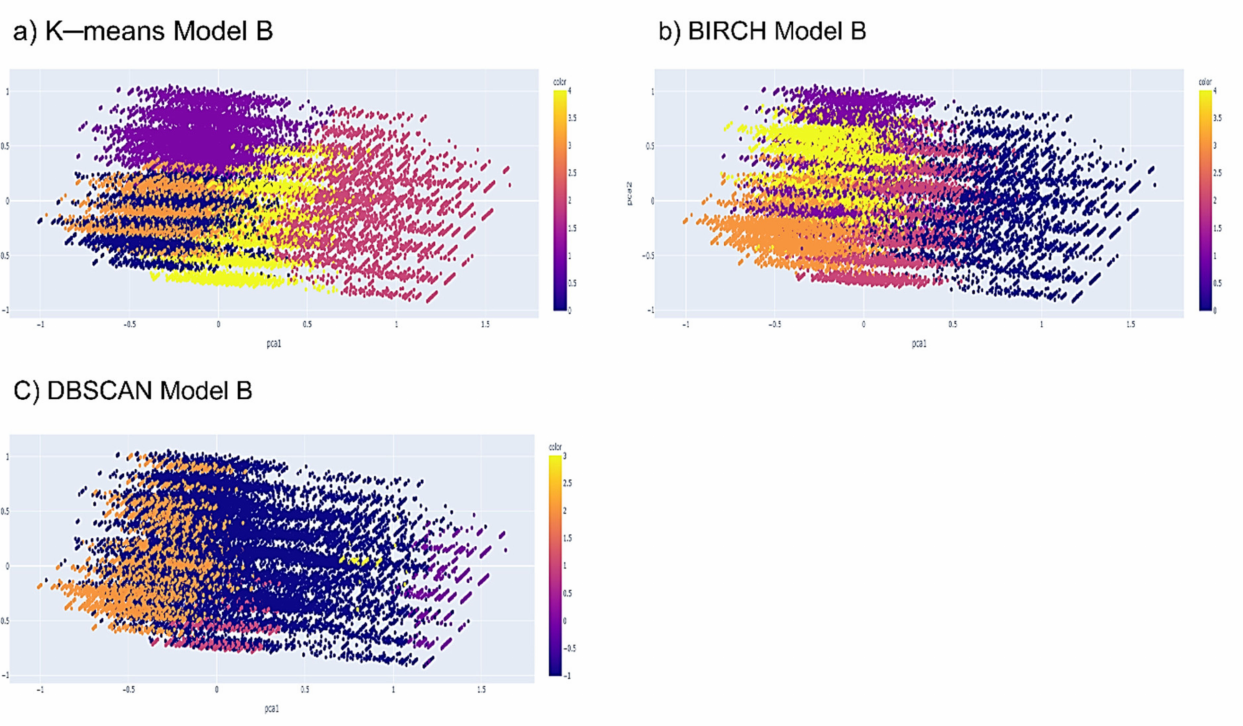
Figure 5. Clustering results of Model B using ( a ) k-means (KMoB); ( b ) BIRCH; ( c )